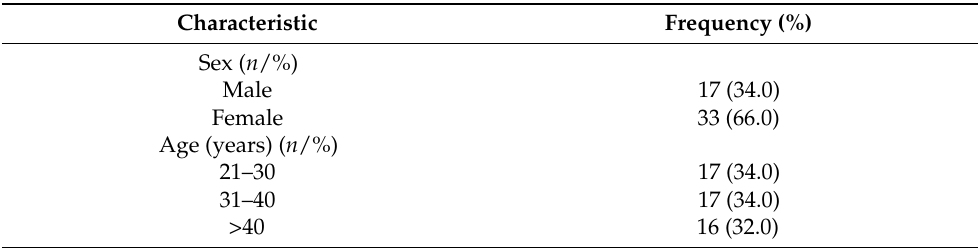
Table 1. Characteristics of